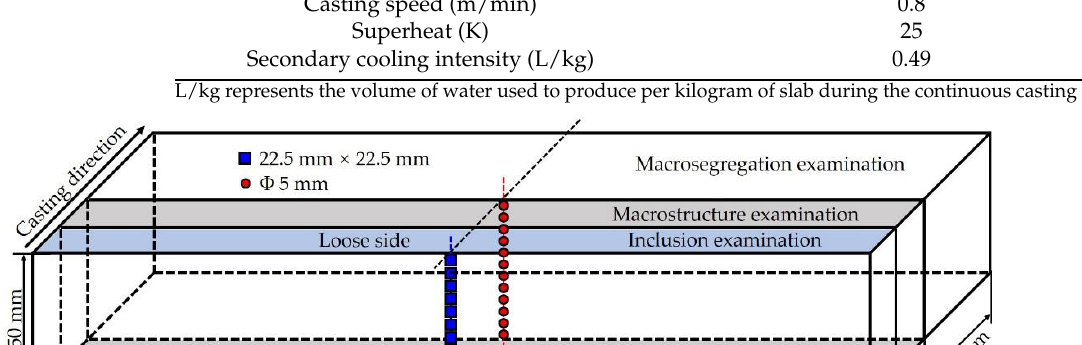
Table 1. Chemical composition of continuous casting slab of 45# medium carbon structural steel.